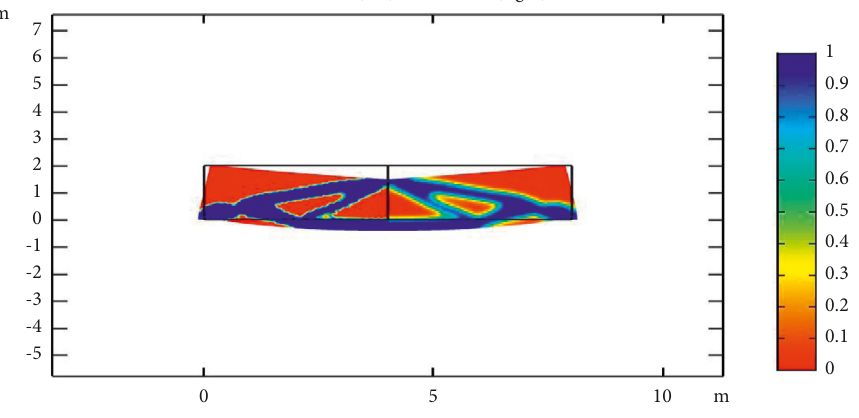
Figure 4: Final stress distribution plot.